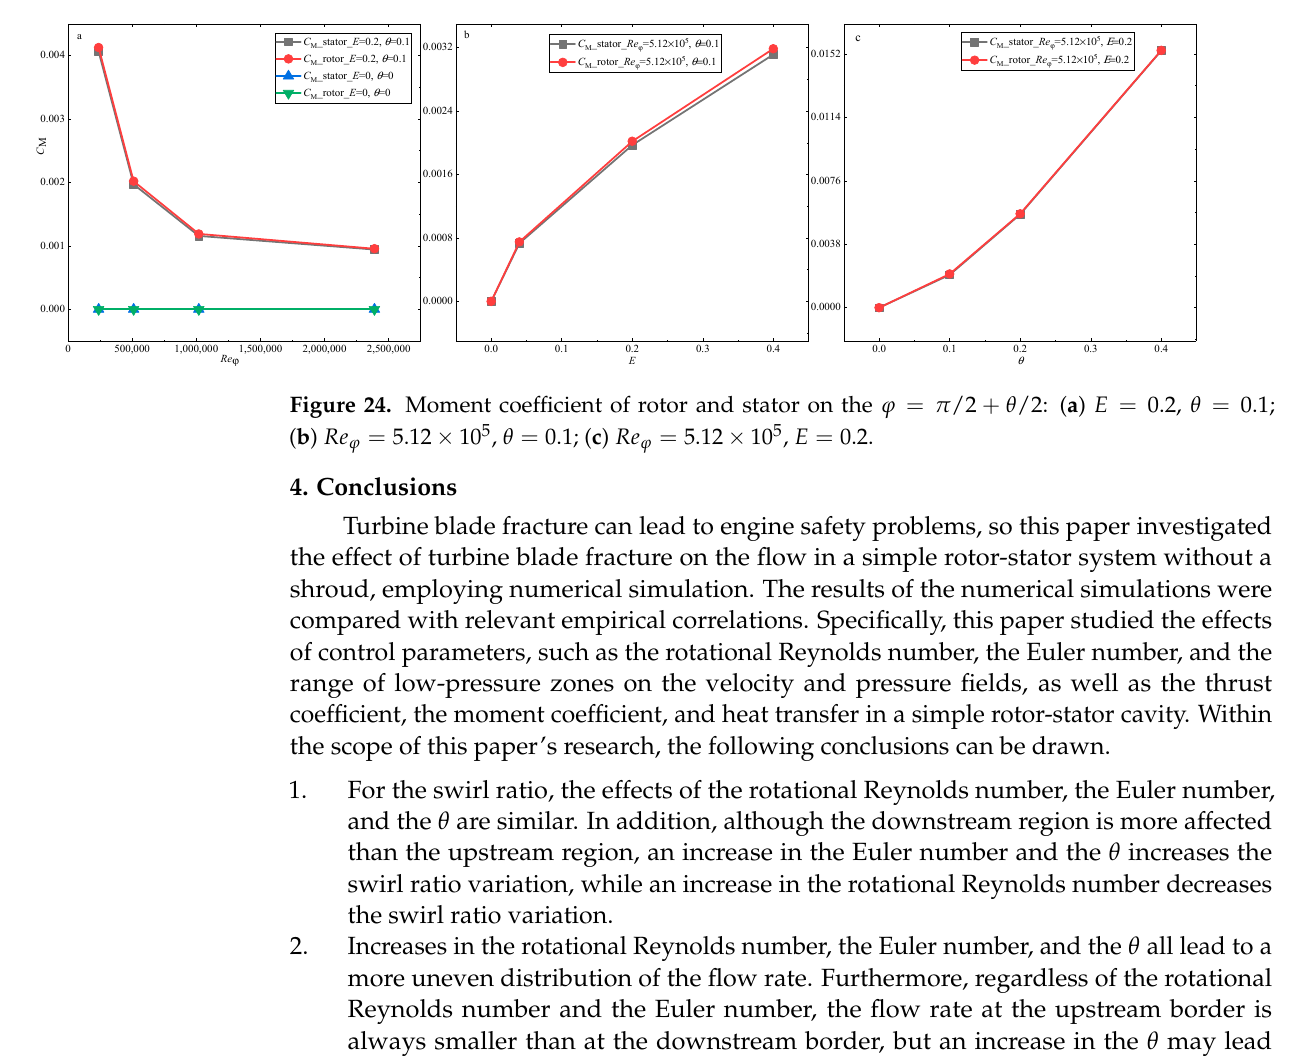
Figure 23. Moment coefficient of rotor and stator on the rotating shaft (z): ( a ) (cid:1831) = 0.2 , (cid:2016) = 0.1 ; ( b ) (cid:1844)(cid:1857) (cid:3101) = 5.12 × 10 (cid:2873) , (cid:2016) = 0.1 ; ( c ) (cid:1844)(cid:1857) (cid:3101) = 5.12 × 10 (cid:2873) , (cid:1831) = 0.2 .